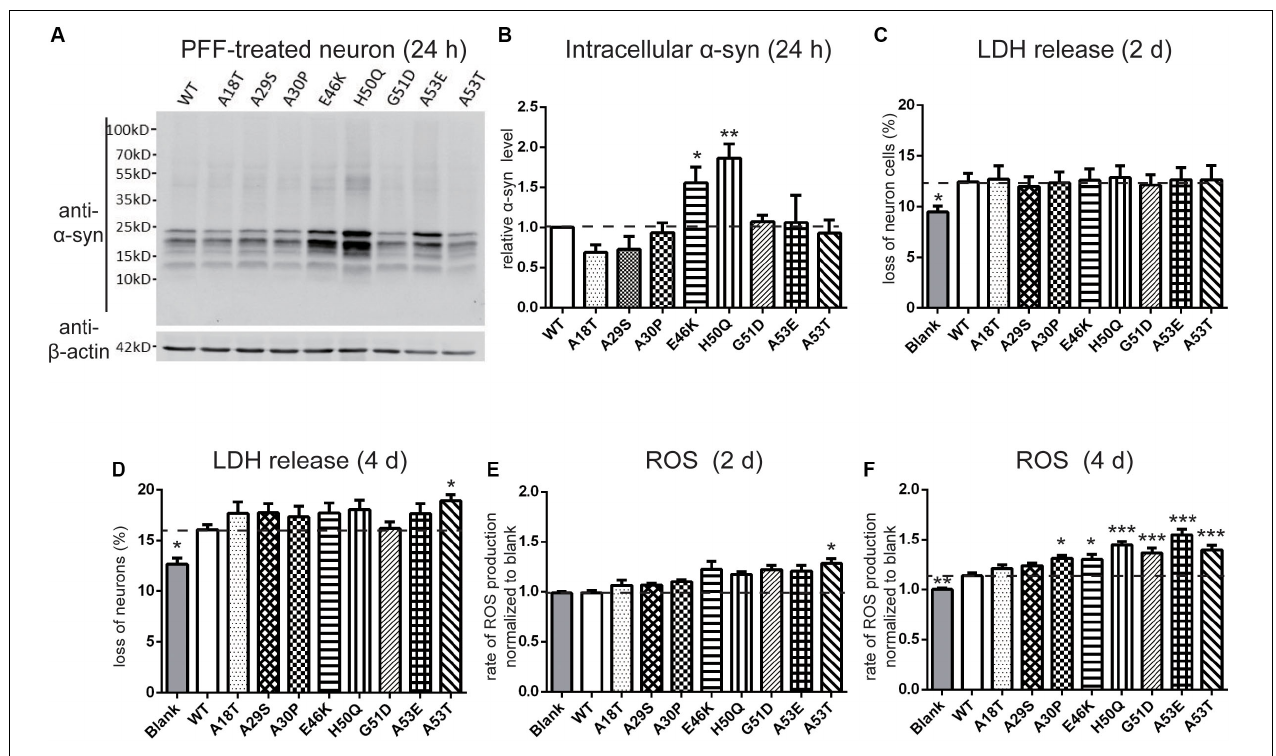
FIGURE 4 | Effects of pathogenic mutations on intracellular α -syn levels and cytotoxicity of extracellular PFF treatment in primary cortical neurons. Neurons were treated with 1 µ M sonicated WT or pathogenic mutant PFFs at 37 ◦ C for 24 h. (A,B) Immunoblots and analysis showing levels of intracellular α -syn. (C,D) Percentages of cell death measured by LDH release after 2 and 4 days treatment with sonicated PFFs. (E,F) ROS assays after PFF treatment. Mean ± SEM; * P < 0.05, ** P < 0.01, *** P < 0.001, one-way ANOVA followed by Dunnett’s test compared to WT; n = 3 independent